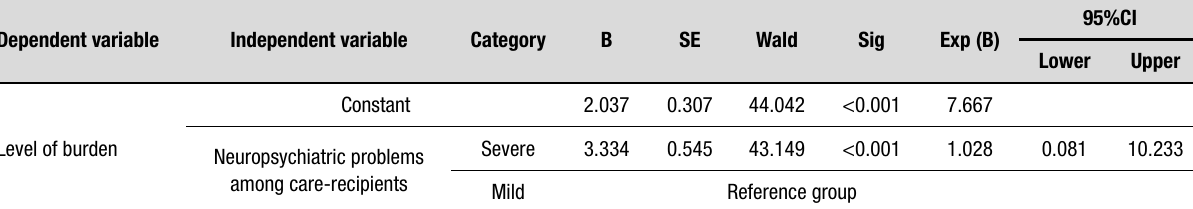
Table 5. Result of logistic regression analysis using care-recipients’ overall neuropsychiatric problems and caregivers’